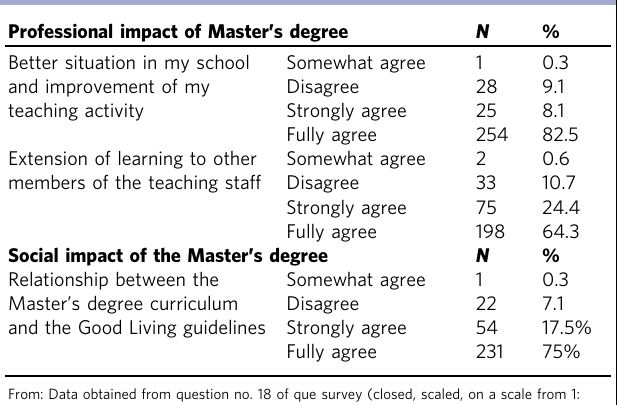
Table 4 Professional value of the degree (%).